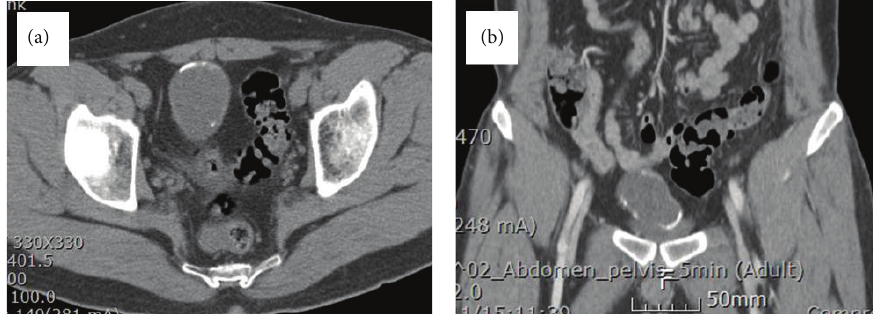
Figure 1: CT scan shows a lobulated cystic mass over the bladder dome which has calcified thick wall and is located at midline to the right side.